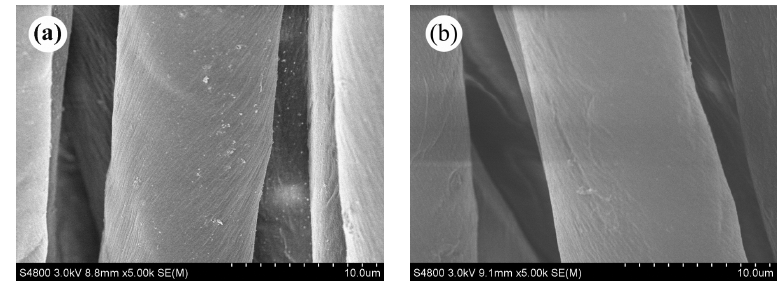
Figure 5. SEM images of ( a ) the blank cotton fabric and ( b ) the PFAS ‐ treated one.